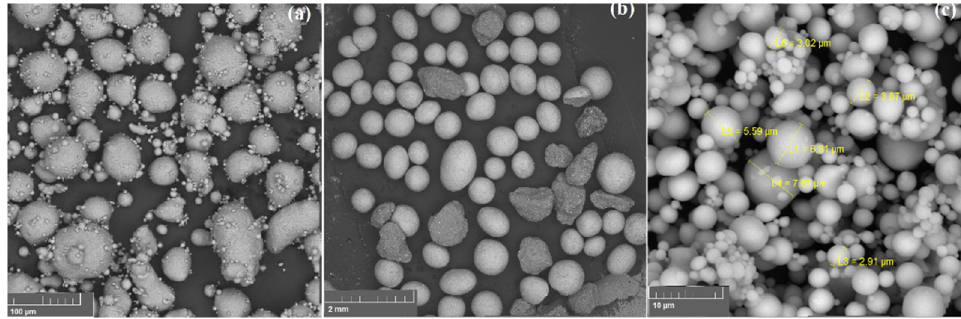
Figure 1. ( a ) Aluminum alloy powder, ( b ) sodium chloride, ( c ) aluminum powder.